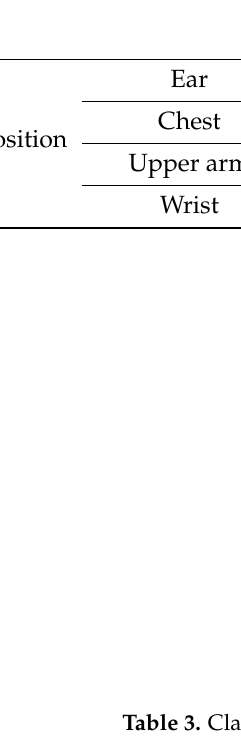
Table 3. Classification performance of randomly selected template exercise segments (50 iterations).